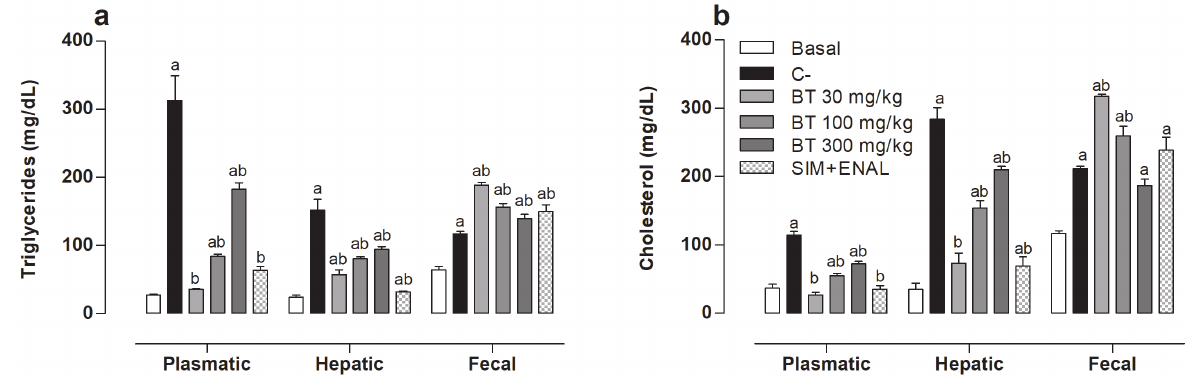
Figure 3. Plasma, hepatic, and fecal levels of (a) triglycerides and (b) cholesterol in normotensive, non- dyslipidemic, and non-smoker Wistar rats (basal group) and hypertensive, dyslipidemic, and smoker Wistar rats that were treated with vehicle (negative control [C–]), Baccharis trimera (30, 100, and 300 mg/kg), and simvastatin + enalapril (SIM+ENAL). n = 8/group. The data are expressed as mean ± SEM. a p < 0.05, vs . basal; b p < 0.05, vs . C– (one-way ANOVA followed by Newman-Keuls post hoc